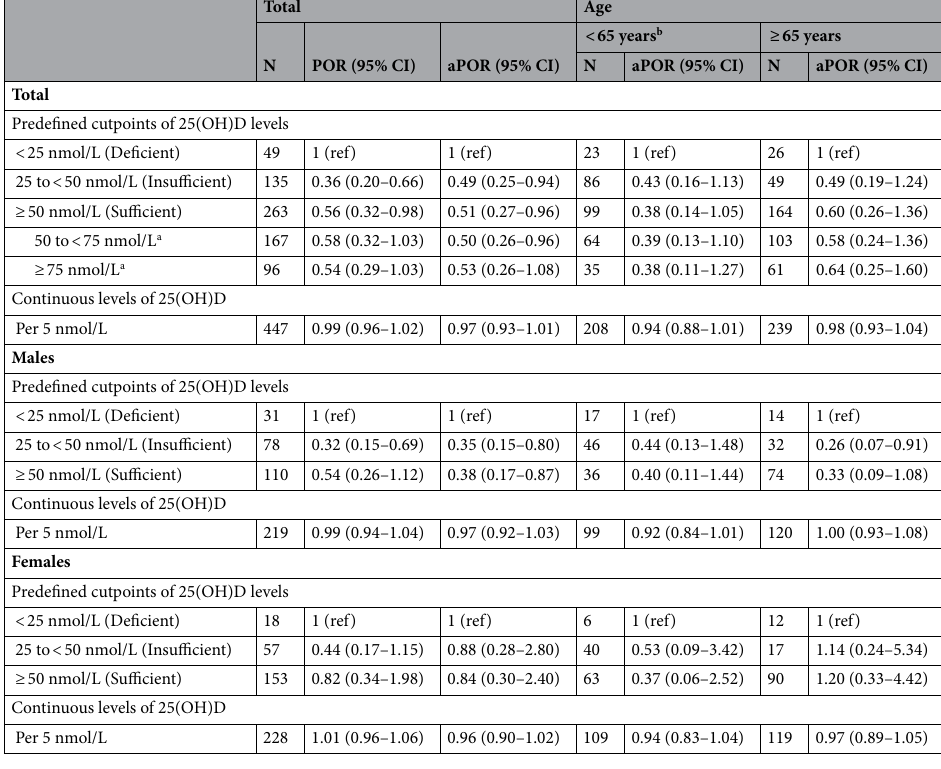
Table 2. Proportional Odds Ratios of developing more severe COVID-19 according to 25(OH)D levels, sex and age. POR Proportional Odds Ratio, CI Confidence Interval, aPOR Proportional Odds Ratio adjusted for age, seasonal variation in vitamin D level, country of origin, Charlson comorbidity index, obesity and sex a Reference group is still the group of individuals with deficient 25(OH)D levels. b Due to few numbers the two highest comorbidity indices are grouped when